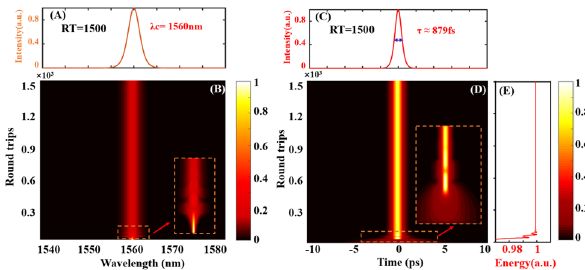
Figure 7: Numerical simulation results of conventional soliton dynamics in 1500 consecutive round trips. (A) Spectral profile with RT = 1500. (B) Spatio-spectral dynamics. Inset: local magni fi cation of the spectral domain. (C) Pulse pro fi le with RT = 1500. (D) Spatio-temporal dynamics. Inset: local magni fi cation of initial pulse evolution. (E) Pulse energy evolution